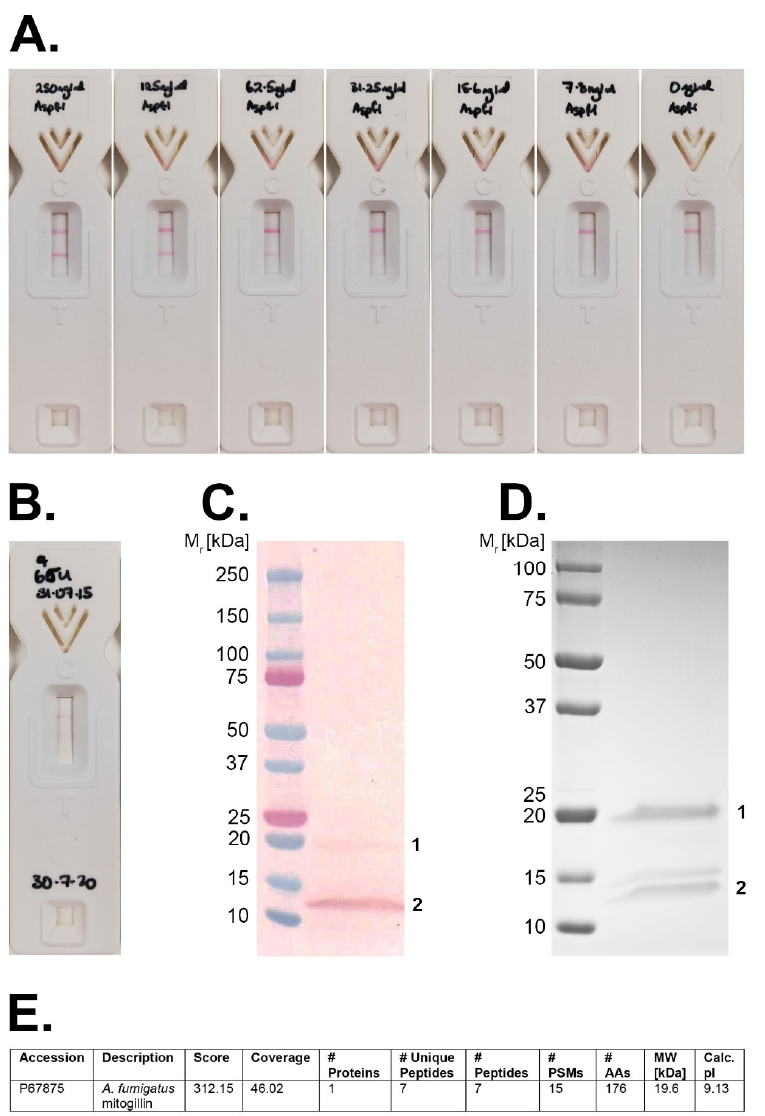
Figure 5. Afu -LFD ® test results and identification of PD7 immuno-reactive proteins in patient urine sample ( A ). Representative Afu -LFD ® test results using first volume urine (FVU) from a healthy donor spiked with known concentrations of A. fumigatus Asp f I protein. Test results were recorded after 30 min as negative [single internal control (C) line only] or positive [both control (C) and test (T) lines visible] for the PD7 protein biomarker. Strong test lines are visible between 250 ng/mL and 31.25 ng/mL, with faint test lines discernible in samples containing 15.6 ng protein/mL and 7.8 ng protein/mL. No test line is evident in control (un-spiked) FVU (0 ng/mL). The limit of detection of the Afu -LFD ® test is therefore estimated to be ~15 ng Asp f I/mL urine. ( B ). Positive test result [control (C) and test (T) lines present] using a urine sample from a patient with acute lymphoid leukaemia and probable IPA. ( C ) The urine sample was subjected to Western blotting with mAb PD7 and revealed two immuno-reactive proteins with molecular weights of ~19 kDa (labelled 1) and ~12.5 kDa (labelled 2). ( D ) Replica SDS-PAGE gel of the patient urine stained with Coomassie. Bands corresponding to the immuno-reactive proteins in ( C ) were excised and subjected to LC–MS analysis. The ~19 kDa protein (labelled 1) was identified as A. fumigatus mitogillin ( E ), synonymous with A. fumigatus Asp f I. The identity of the ~12.5 kDa protein (labelled 2) could not be established using this